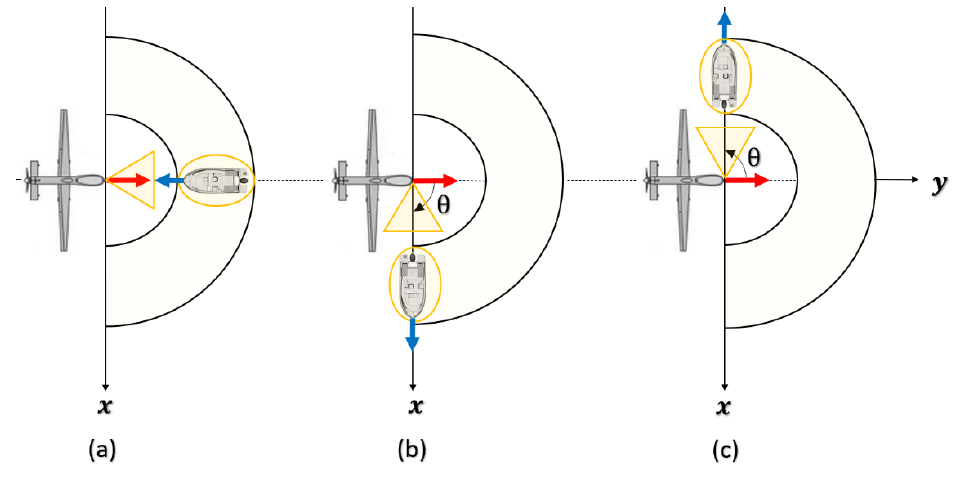
Figure 17. ( a ) Geometry corresponding to the maximum Doppler frequency of target; ( b , c ) geometries corresponding to the minimum Doppler frequency of target.